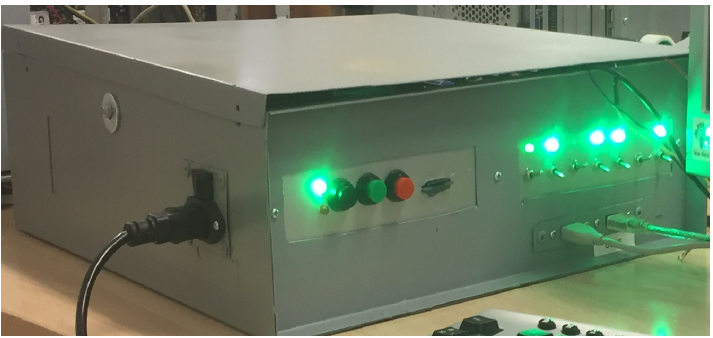
Figure 4. EET hardware.